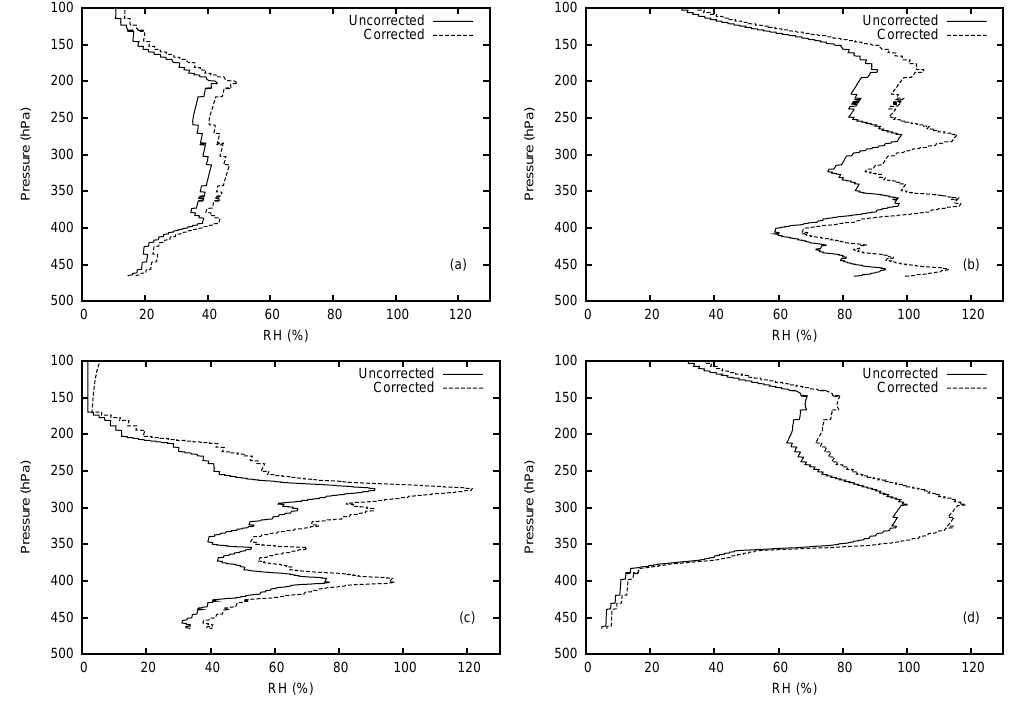
Fig. 1. A selection of example RHi profiles, corrected and uncorrected, from January 2004 from the Watnall high resolution radiosonde station using RS80-H radiosondes. These data are corrected for temperature dependency, chemical contamination and sensor ageing using the algorithm of Wang et al. (2002).